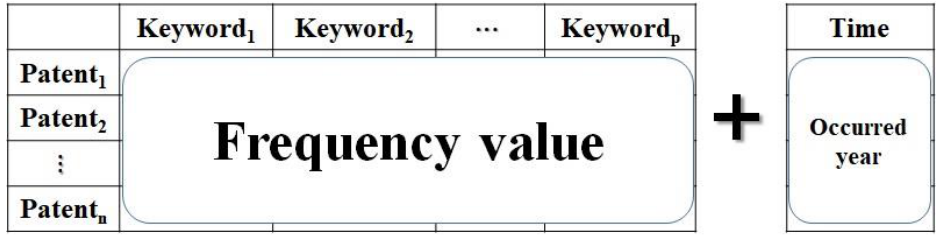
Figure 1. Patent-keyword matrix with a time factor.